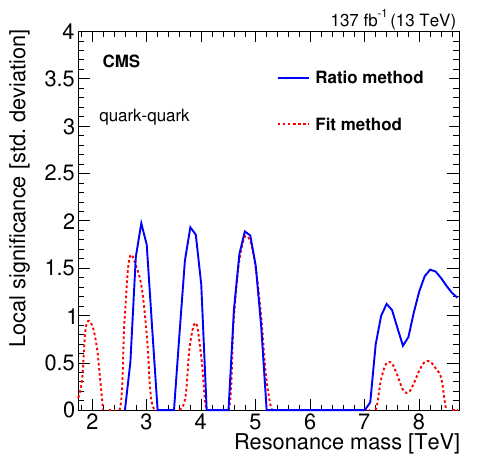
Figure 8 . Local signi(cid:12)cance for a qq resonance with the ratio method (blue line) and the (cid:12)t method (red dashed line).